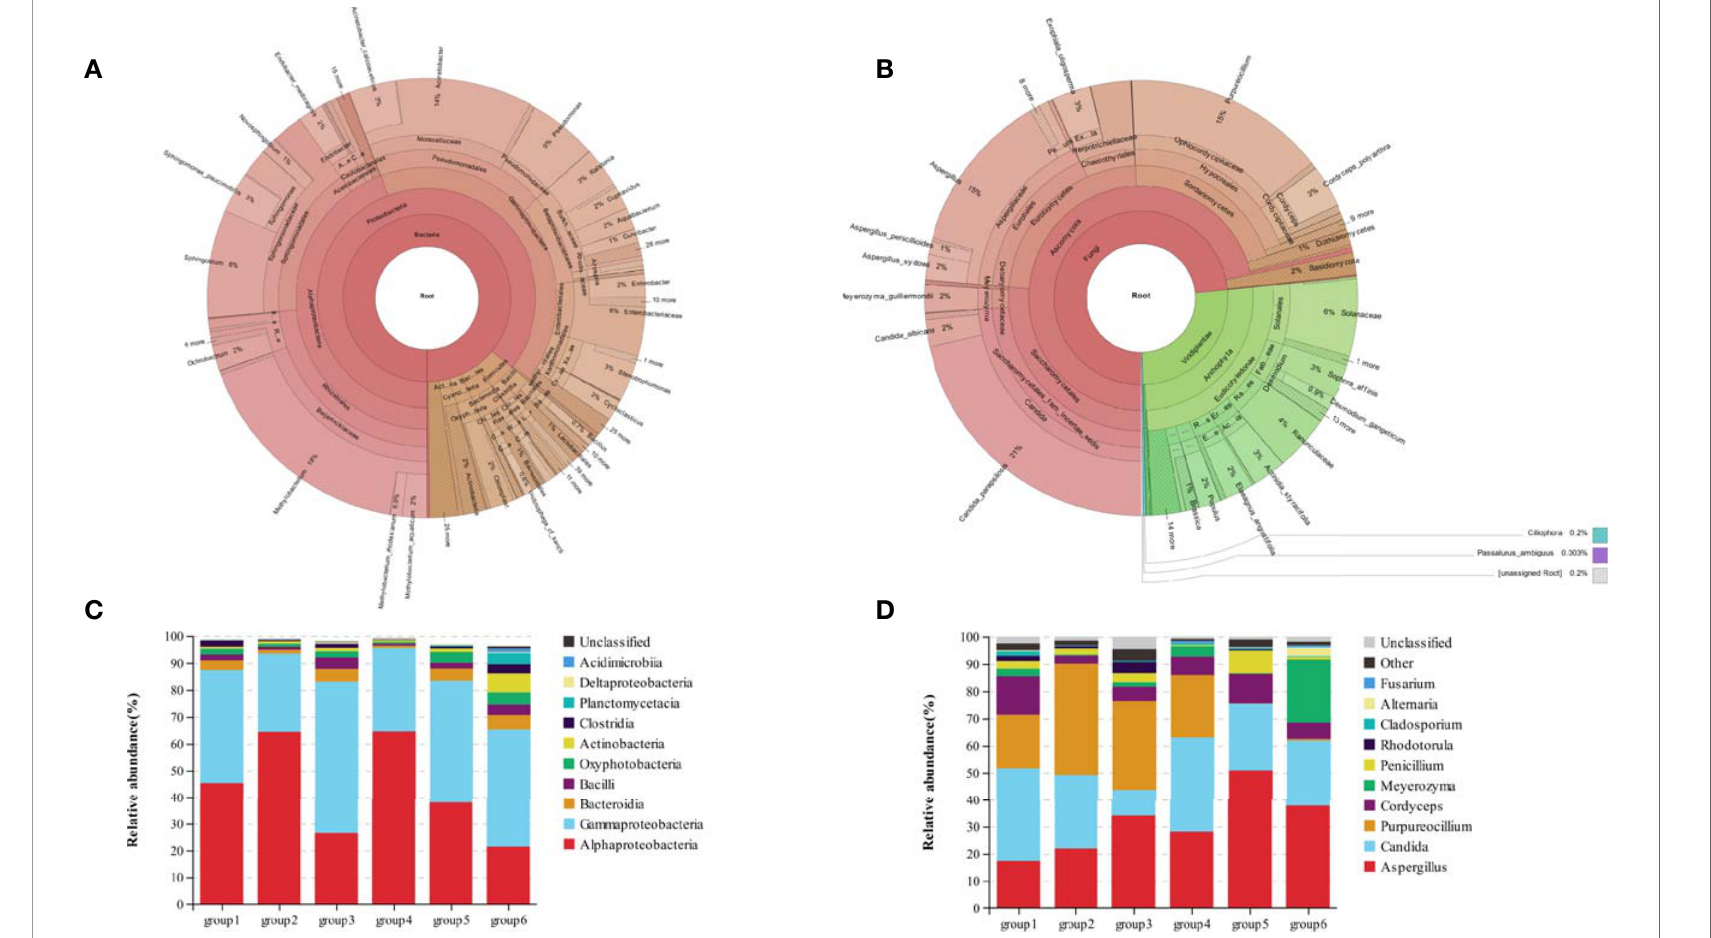
FIGURE 1 | The relative abundance of bacterial (A) and fungal (B) genera in the DUWL core microbiome; relative abundance of bacterial community compositions at class level in six groups (C) ; relative abundance of fungal community compositions at genus level in six groups (D)